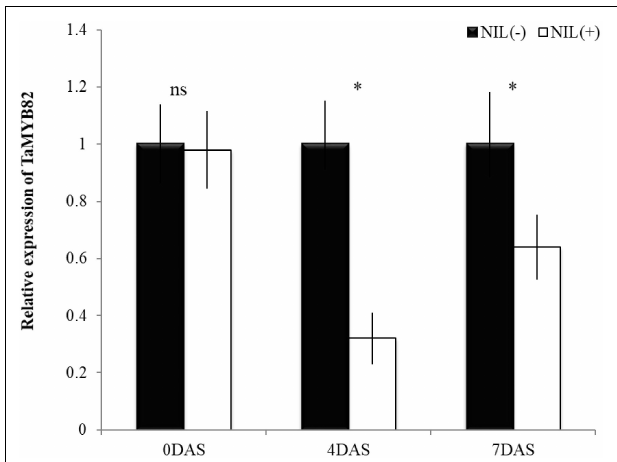
FIGURE 5 | Relative expression of TaMYB82 gene in +NIL and –NIL during stress period. Mean fold change in gene expression (2 − (cid:49)(cid:49) C T) of –NIL was set to 1 at each time point to determine relative expression in +NIL. Each value represents mean ± SD of three biological replicates with three technical replicates. ns = non-significant at P ≤ 0.01; ∗ = significant at P ≤